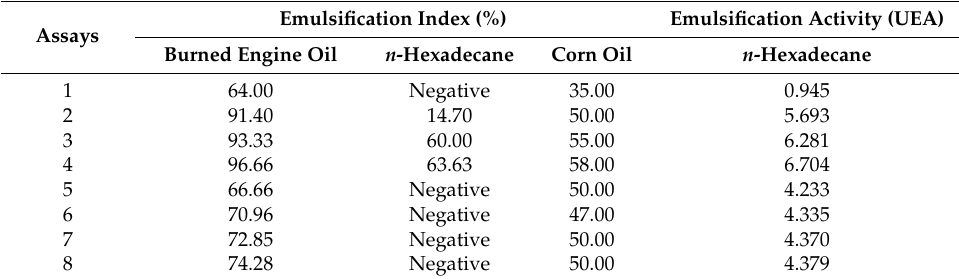
Table 1. Bioemulsifier production by C. lipolytica using factorial design.